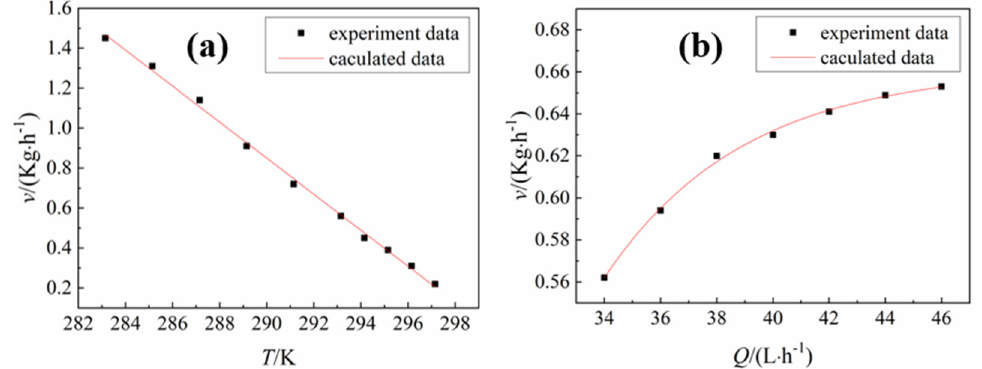
Figure 7. ( a ) Effect of cooling water temperature on the crystallization rate at a flow rate of 40 L·h − 1 ; ( b ) effect of cooling water flow rate on the crystallization rate at 293